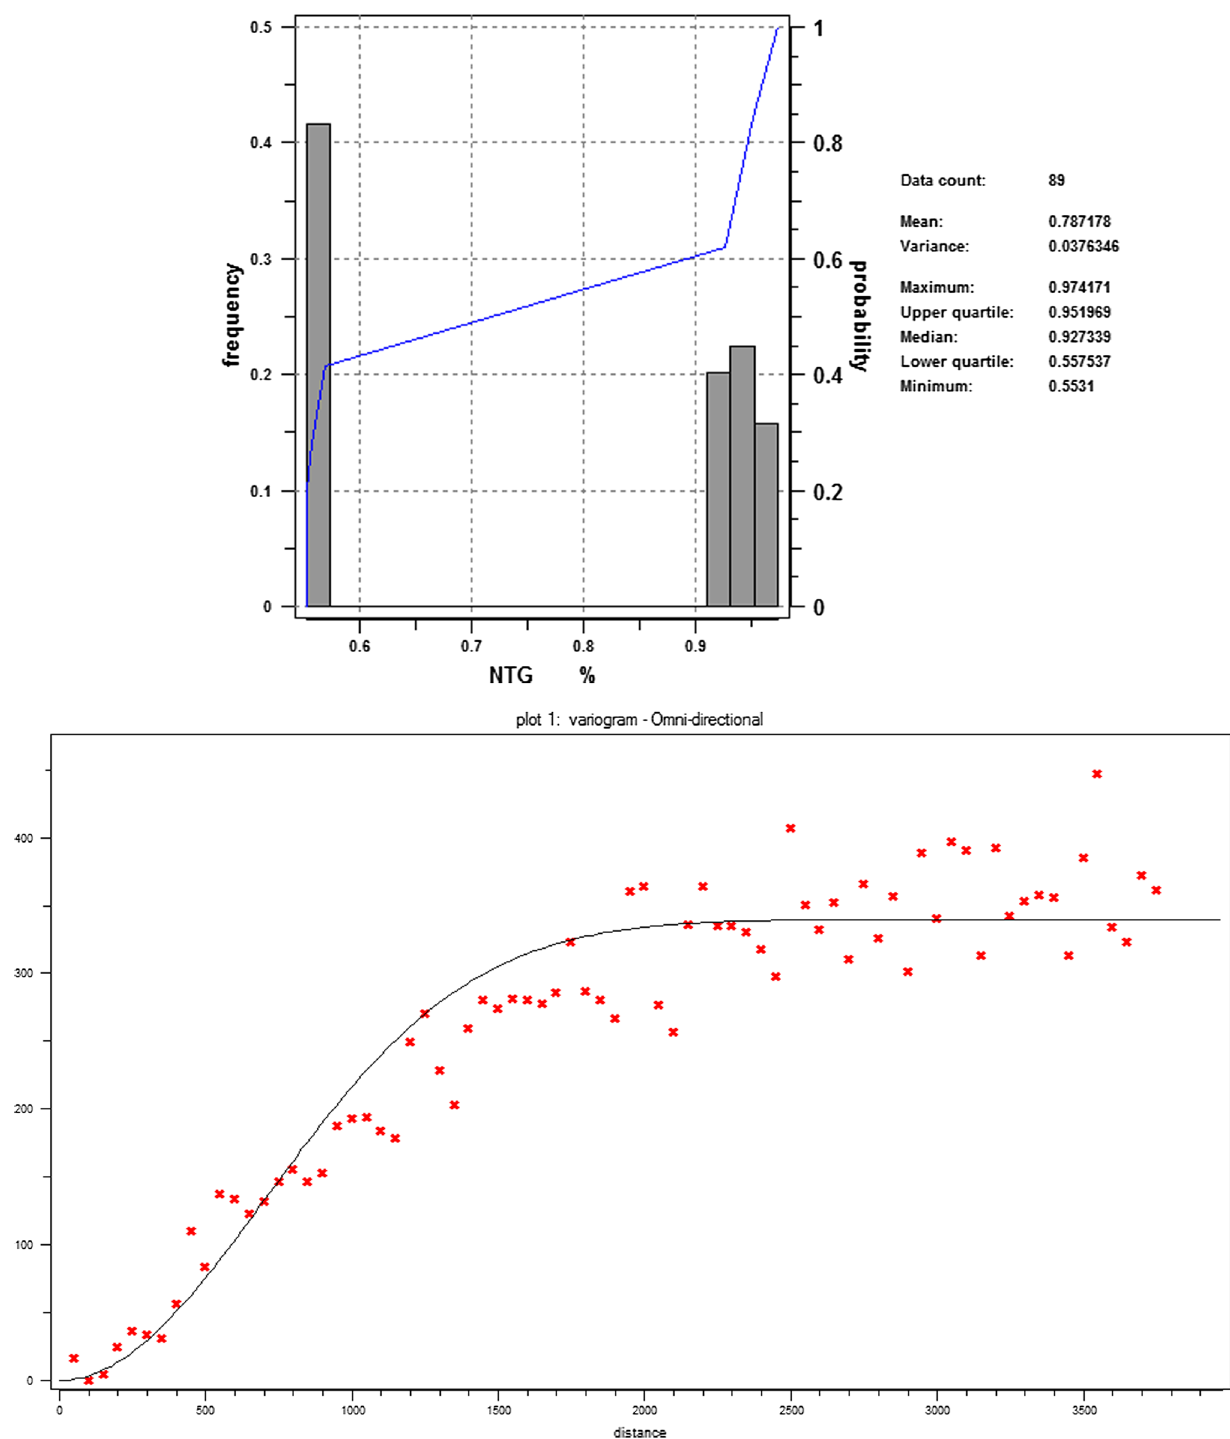
Fig. 5 Histogram and variogram for net to gross across the